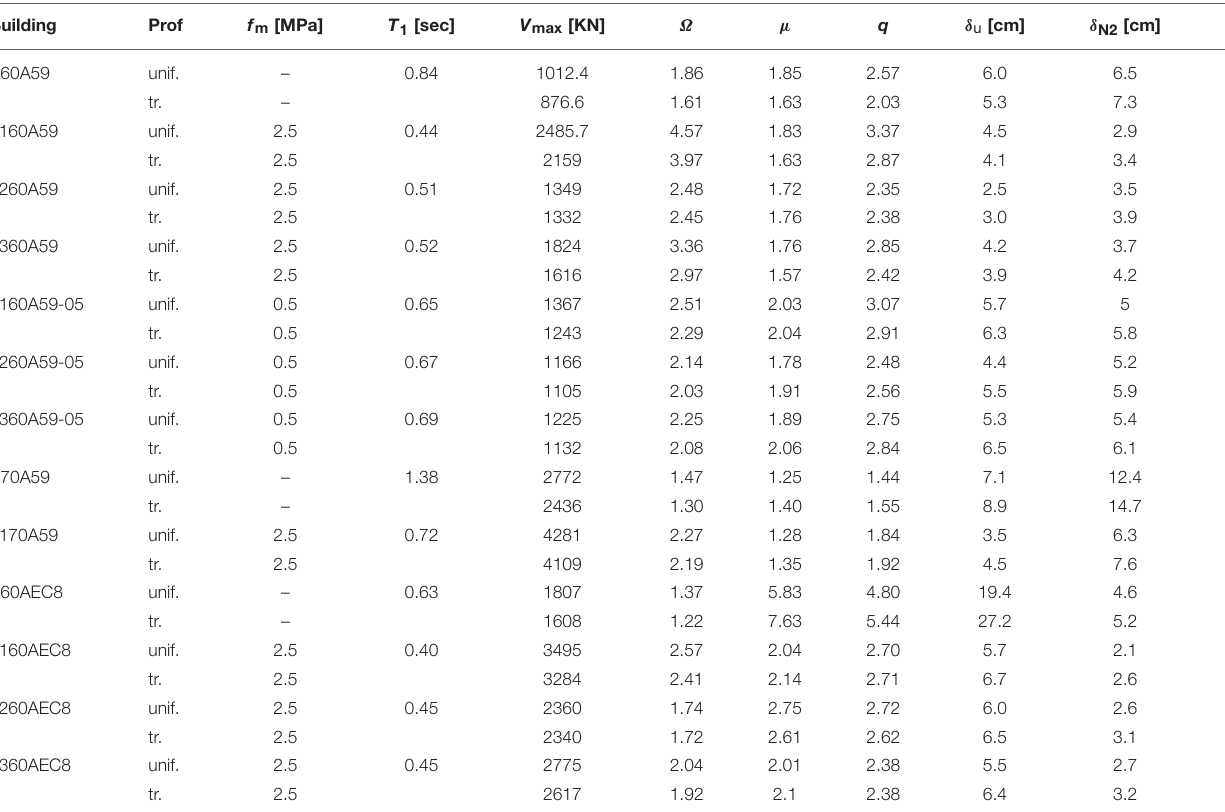
TABLE 1 | SPO analyses results for uniform and triangular distribution of lateral loads.